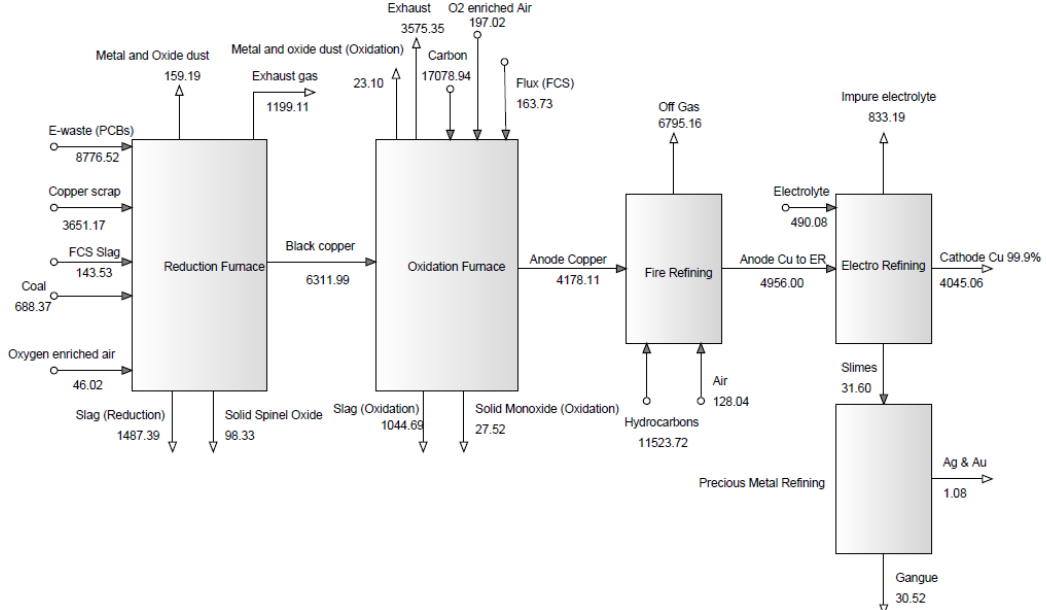
Figure 5. Total exergy balance (kWh), 30% e-waste in the throughput.